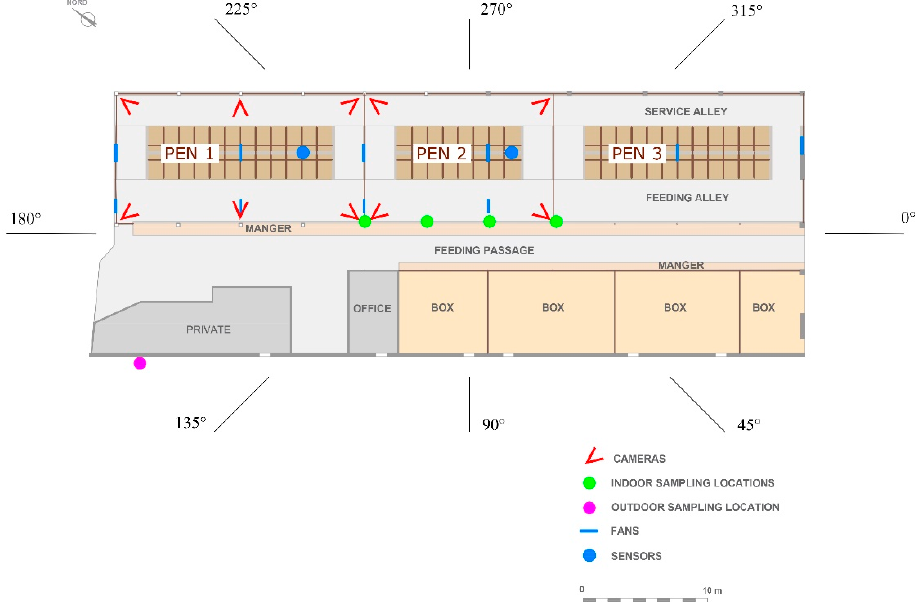
Figure 1. Plan view of the barn and position of sampling locations, cameras, fans and